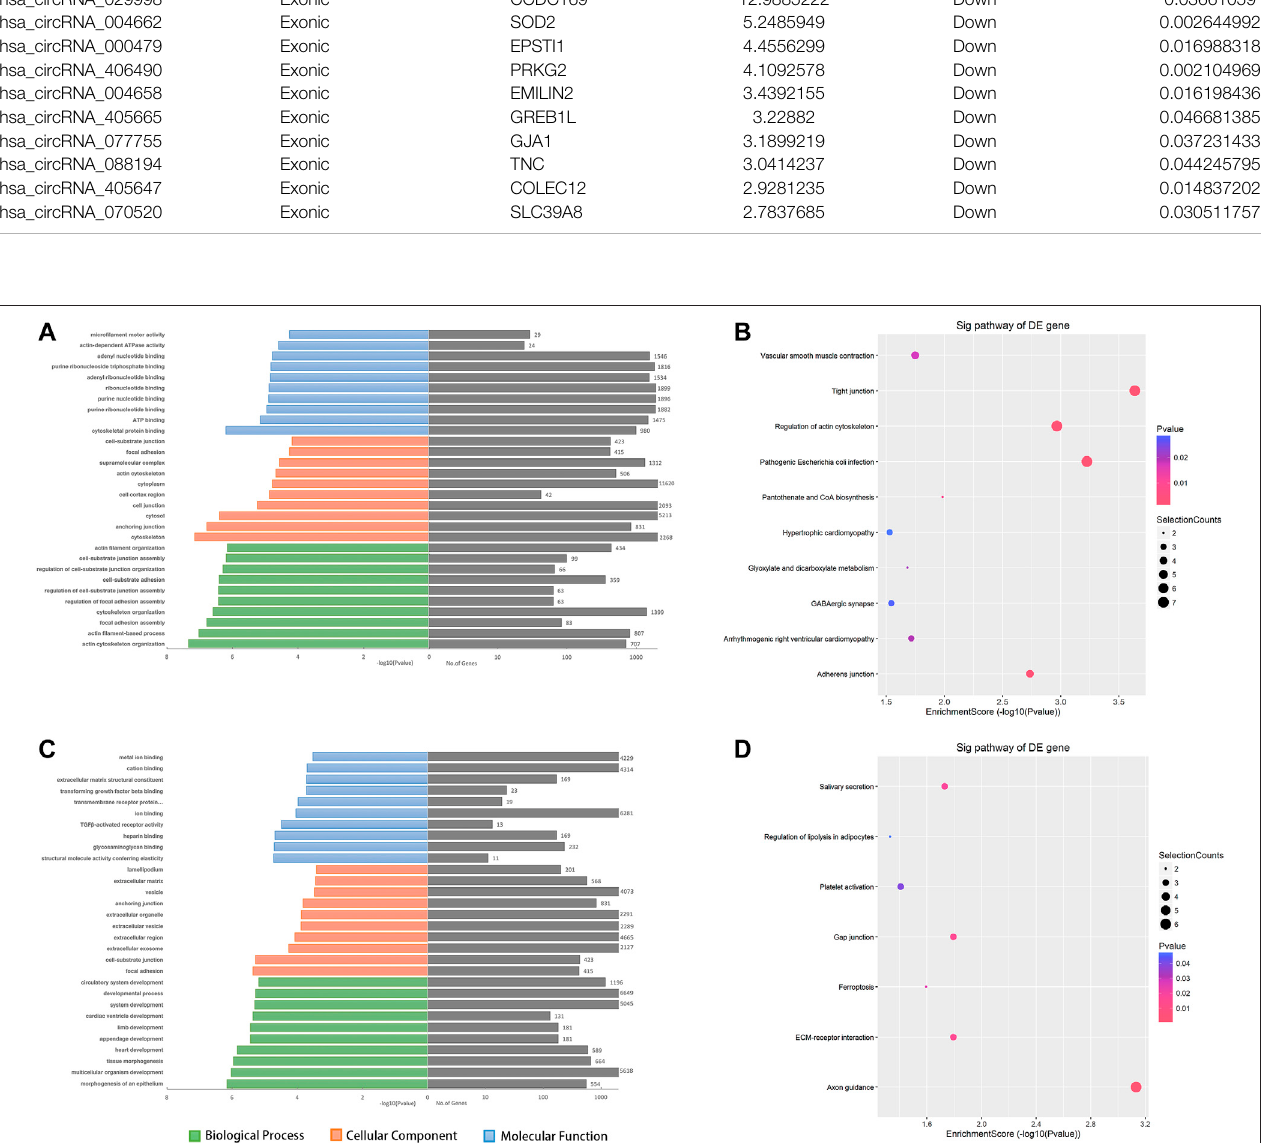
Frontiers in Molecular Biosciences |